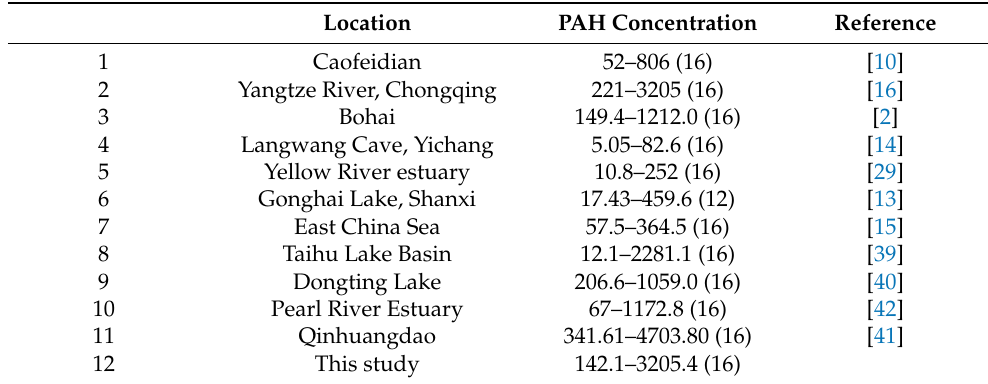
Table 3. Residues of PAHs in soils in China ( µ g · kg − 1